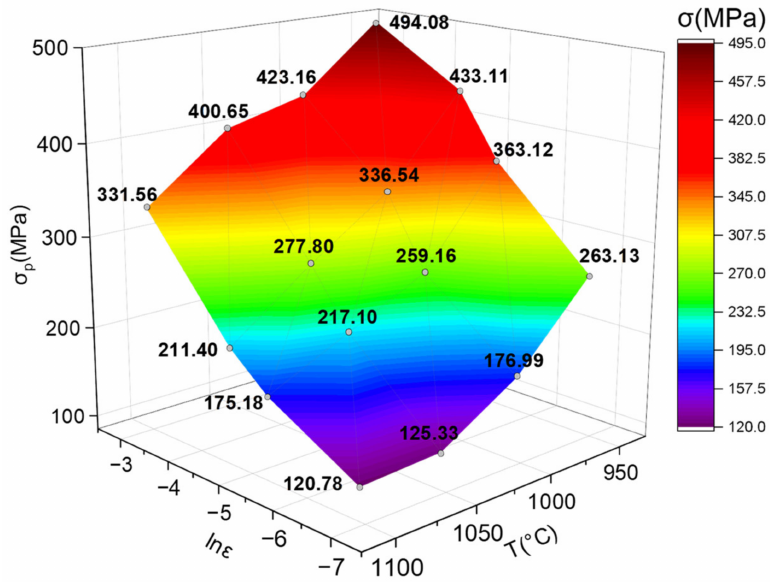
Figure 4. The peak stress at different deformation temperature and strain